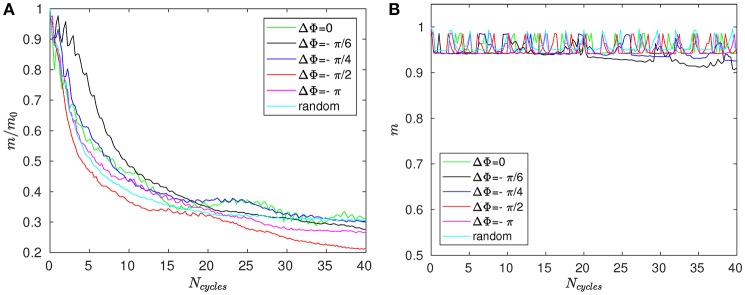
Mixing number m/m0 as a function of the number of cycles Ncycles for Re = 2.10−2 and different phase lags ΔΦ in (A) area 1 (i.e., within the PCL) and (B) in area 3 (far above the mucus–PCL interface).